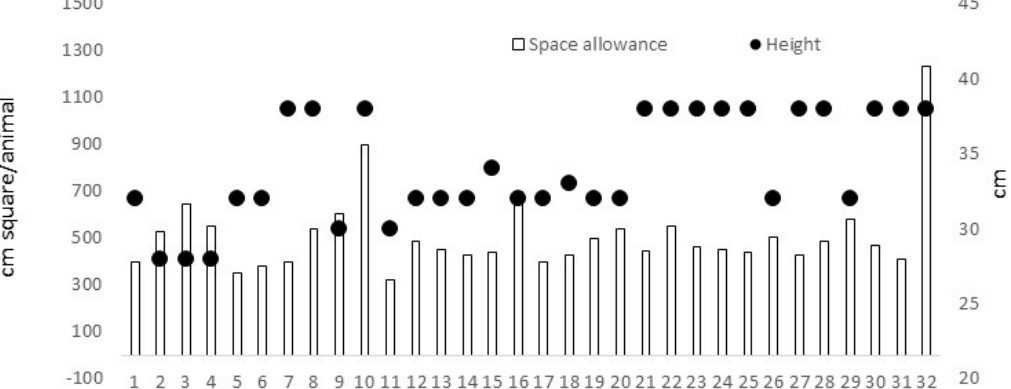
Figure 1. Space allowance (cm 2 per animal) and height (cm) of the cages in growing-rabbit farms (n = 32). For space allowance, excellent is considered when at least 1500 cm 2 are provided per animal in 90% of the cages and acceptable when this is at least 500 cm 2 per animal. The height of the cage is considered excellent when at least 38 cm are provided in 90% of the cages and acceptable when this is at least 32 cm.